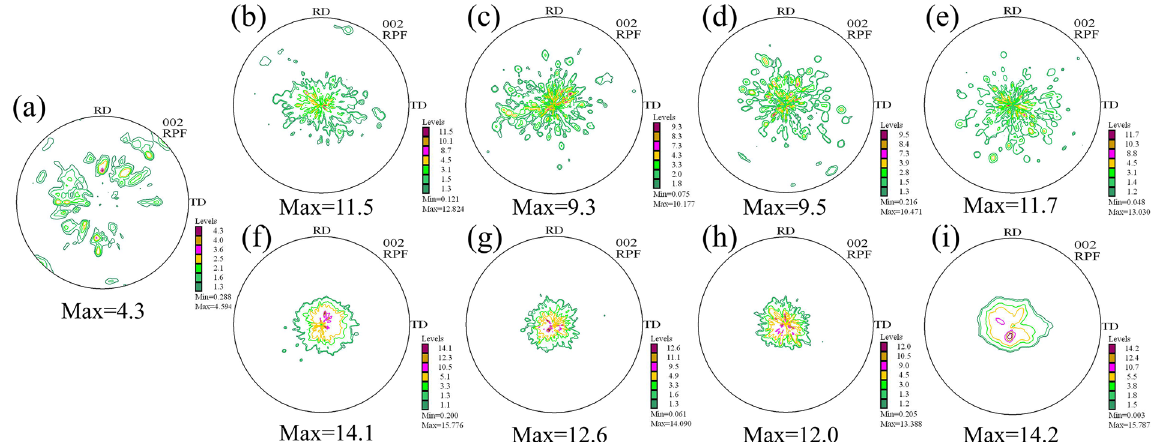
Figure 6. (0002) macrotextures of Mg-5Zn alloy in various states: ( a ) cast, ( b ) rolled (20%) and subjected to solution treatment at 420 °C for 24 h; ( c ) further aged at 170 °C for 10 h, ( d ) 25 h, and ( e ) 60 h; and ( f ) rolled (50%) and subjected to solution treatment at 420 °C for 24 h and ( g ) further aged at 170 °C for 10 h, ( h ) 25 h, and ( i ) 60 h.